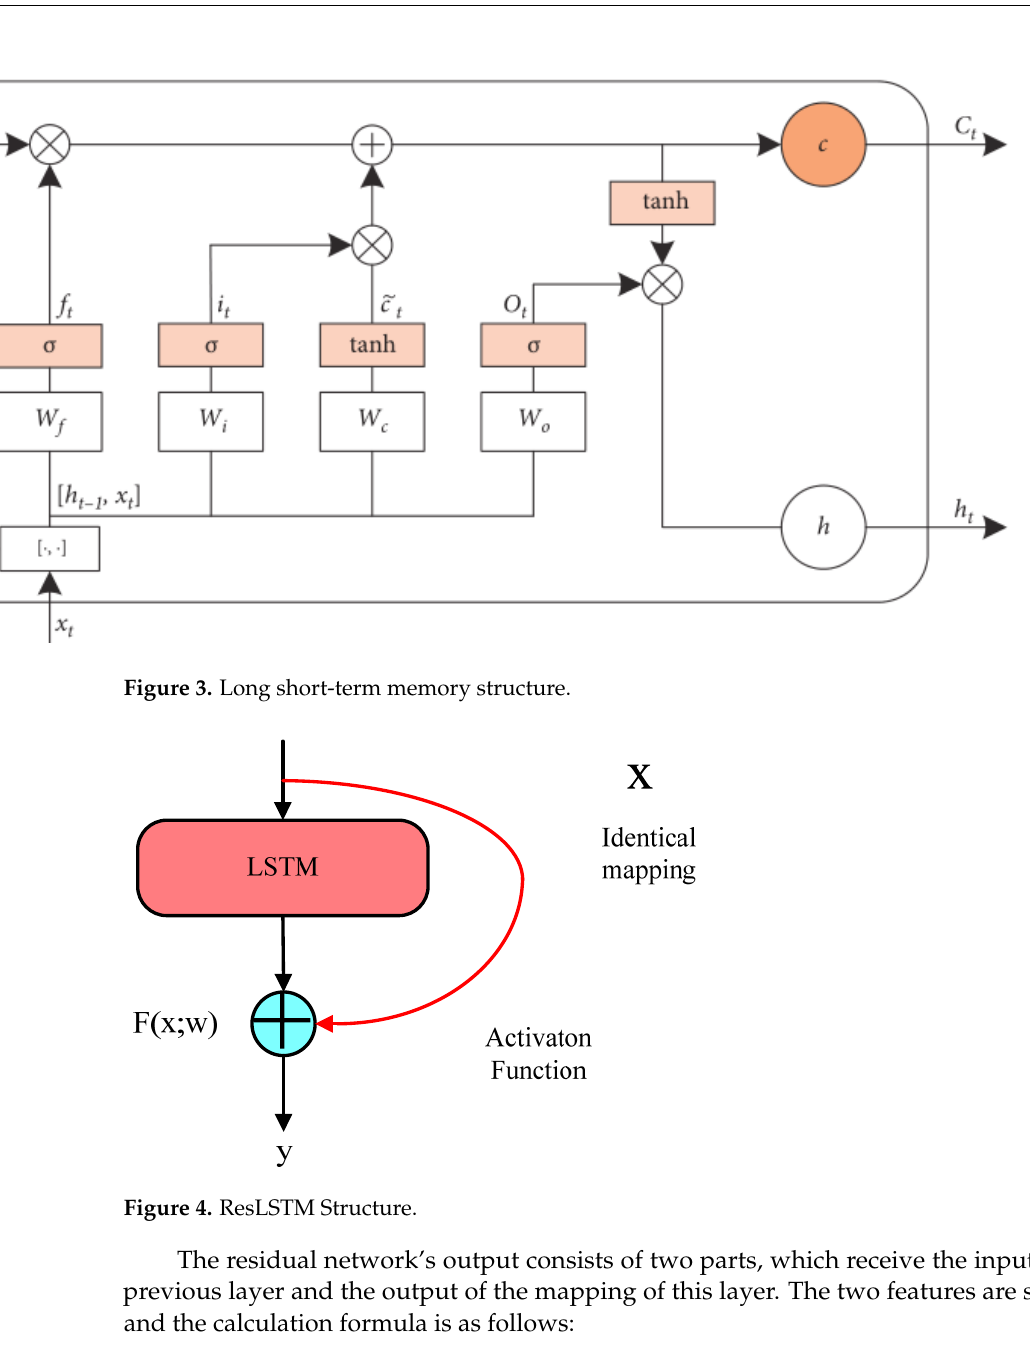
Figure 4. ResLSTM Structure.